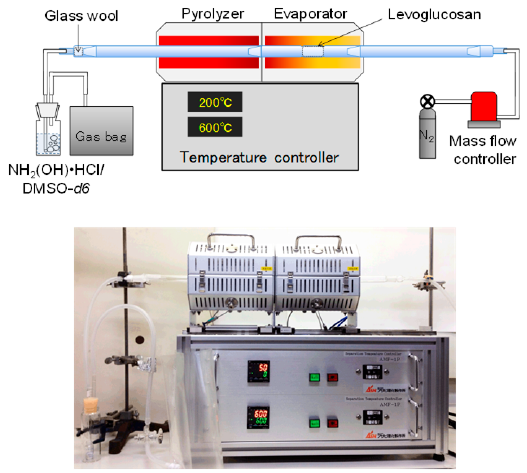
Figure 2. A flow-type two-stage tubular reactor consisting an evaporator connected to a pyrolyzer and product recovery unit.